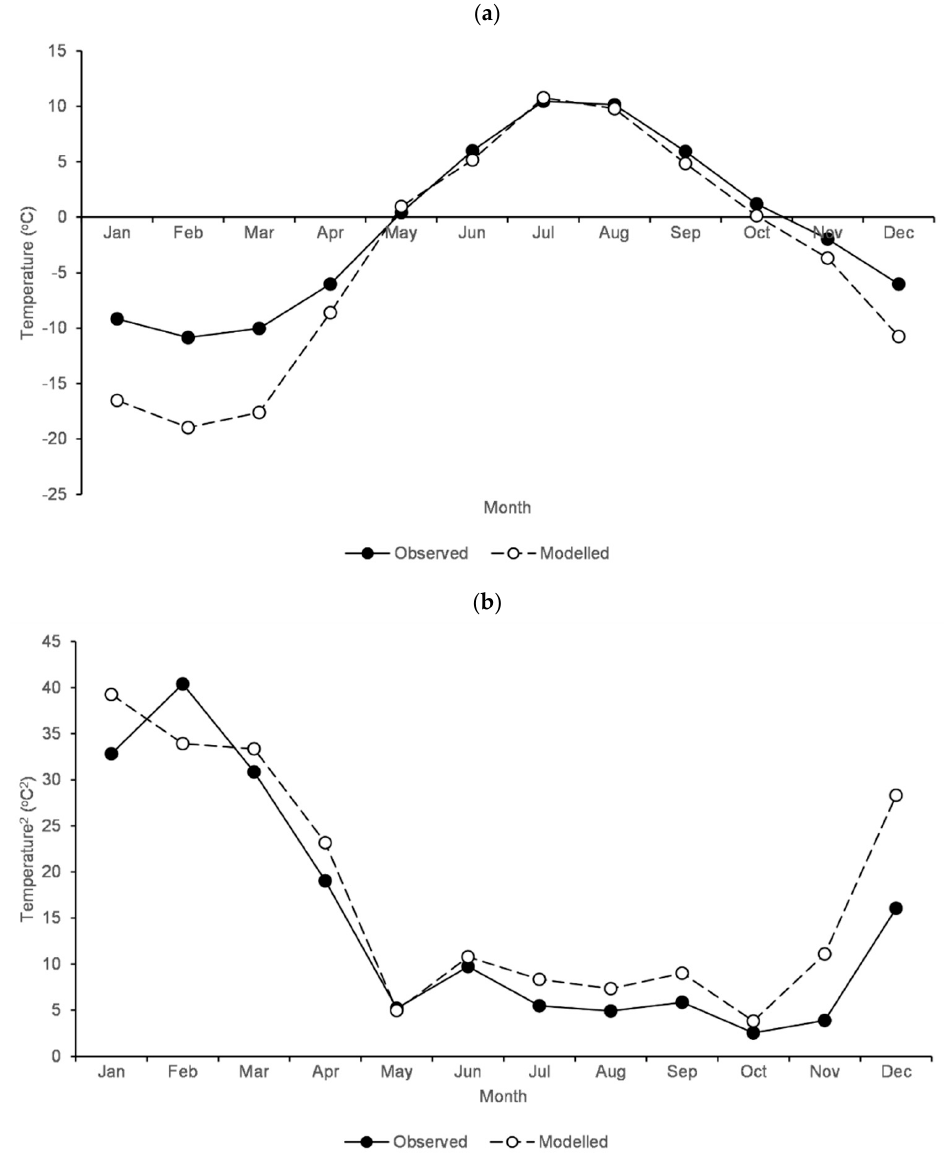
Figure 5. Comparison between the observed monthly 20 cm soil temperature and the predicted values from the CanESM2 and NCEP models for: ( a ) mean; ( b ) variance.